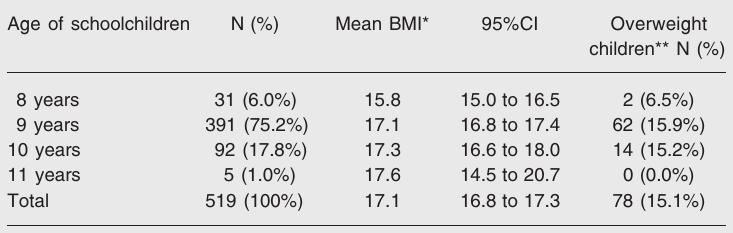
*P = 0.064 (ANOVA for mean differences); **P = 0.41 ( χ 2 test for frequency differ- ences).